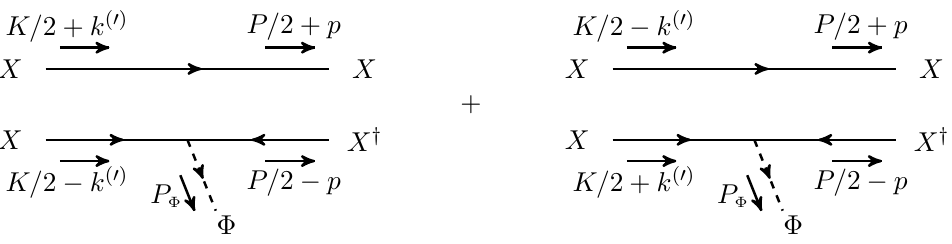
Figure 4 . The radiative part of transitions via emission of a charged scalar, XX ! XX y + (cid:8). The arrows on the (cid:12)eld lines denote the (cid:13)ow of the U(1) D